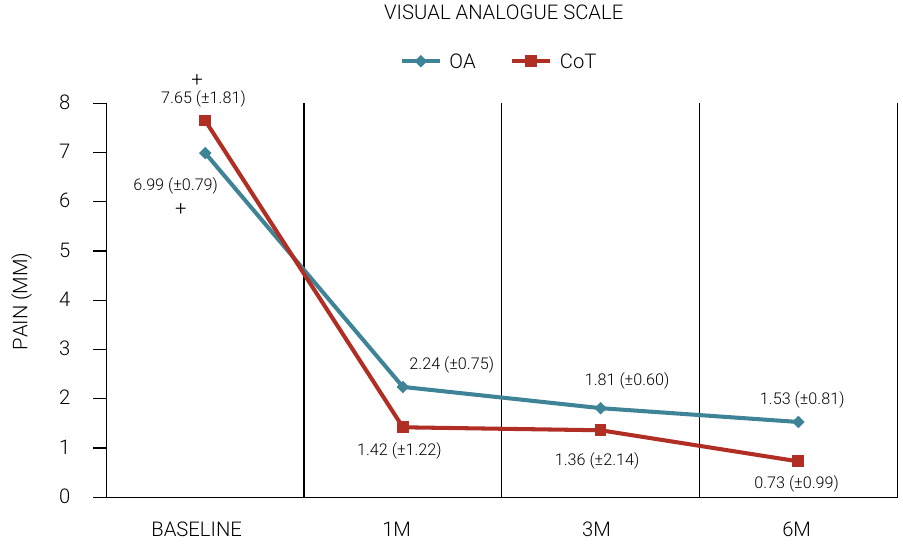
Figure 2. Visual Analogue Scale (VAS). Occlusal appliance (OA) and combined therapy (CoT) decreased pain intensity assessed by VAS after 1 month and maintained up to 6-months. Mean ± standard deviation; +=p<0.001 within group (one-way ANOVA followed by Tukey´s multiple comparisons test). However, no significant differences were found among groups throughout the experiment (p>0.05; two-way repeated measures ANOVA followed by Tukey´s multiple comparisons